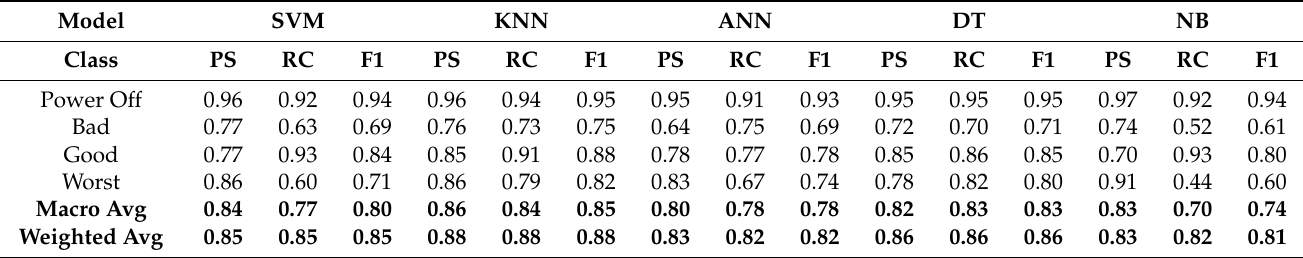
Table 8. The comparative effectiveness of Target based on partial hyperparameter